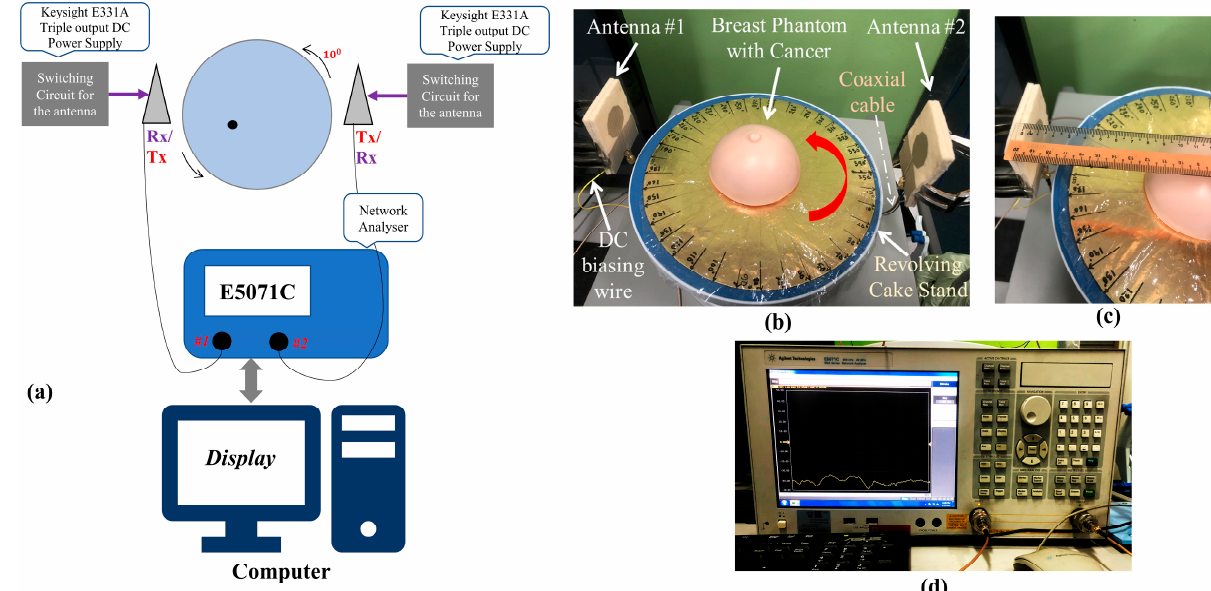
Figure 21. ( a ) Depiction of the data acquisition setup in this study, where the antennas are represented by the triangle shape surrounding the breast. Microwave imaging experimental setup: ( b ) photograph of MBRU ‐ based setup; ( c ) maintaining the distance from antennas to breast phantom; ( d ) sample of backscattering data measurements.